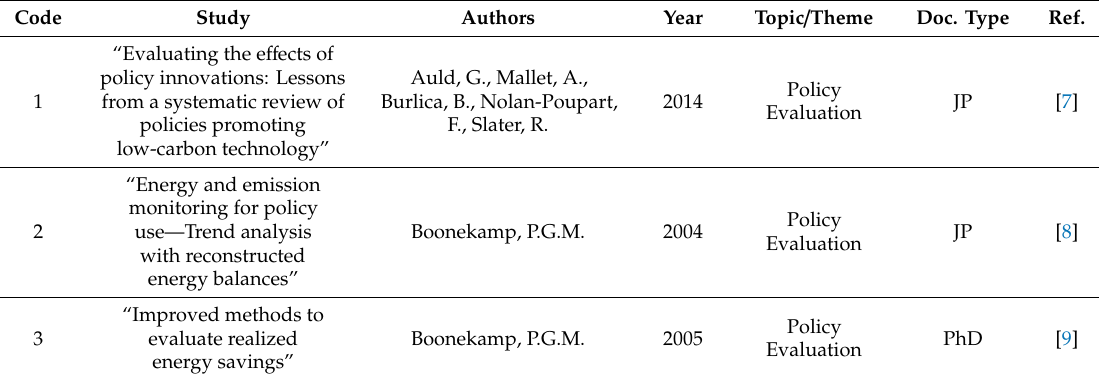
Table 2. Characterization of the documents used for the identification of the factors of